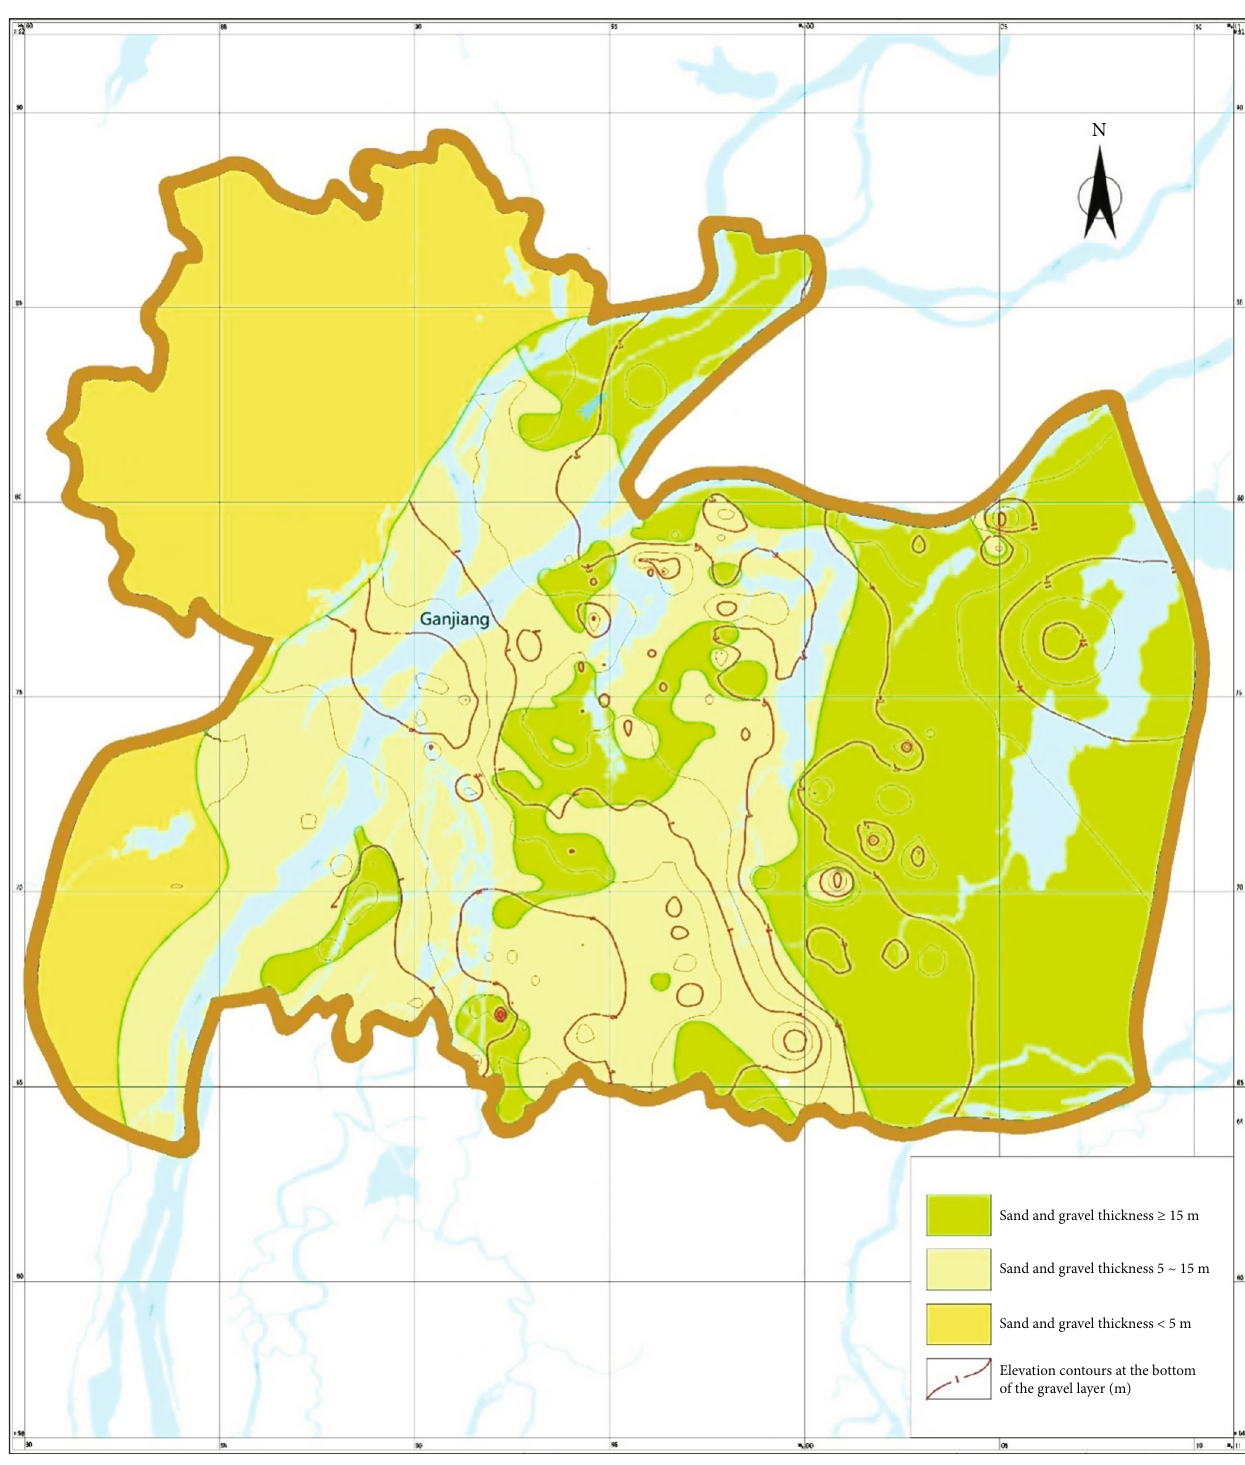
Figure 2: Zoning map of the Quaternary gravel layer